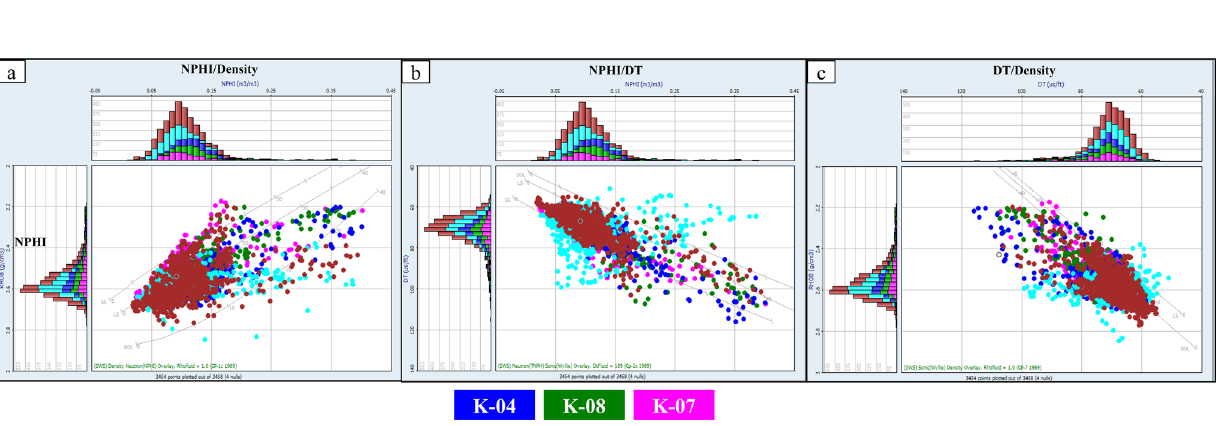
Fig. 7 Multi-wells (five wells data—only three wells names are disclosed due to data confidentiality) cross-plot distribution of density, sonic and neutron porosity logs after conditioning of the target reservoir zone